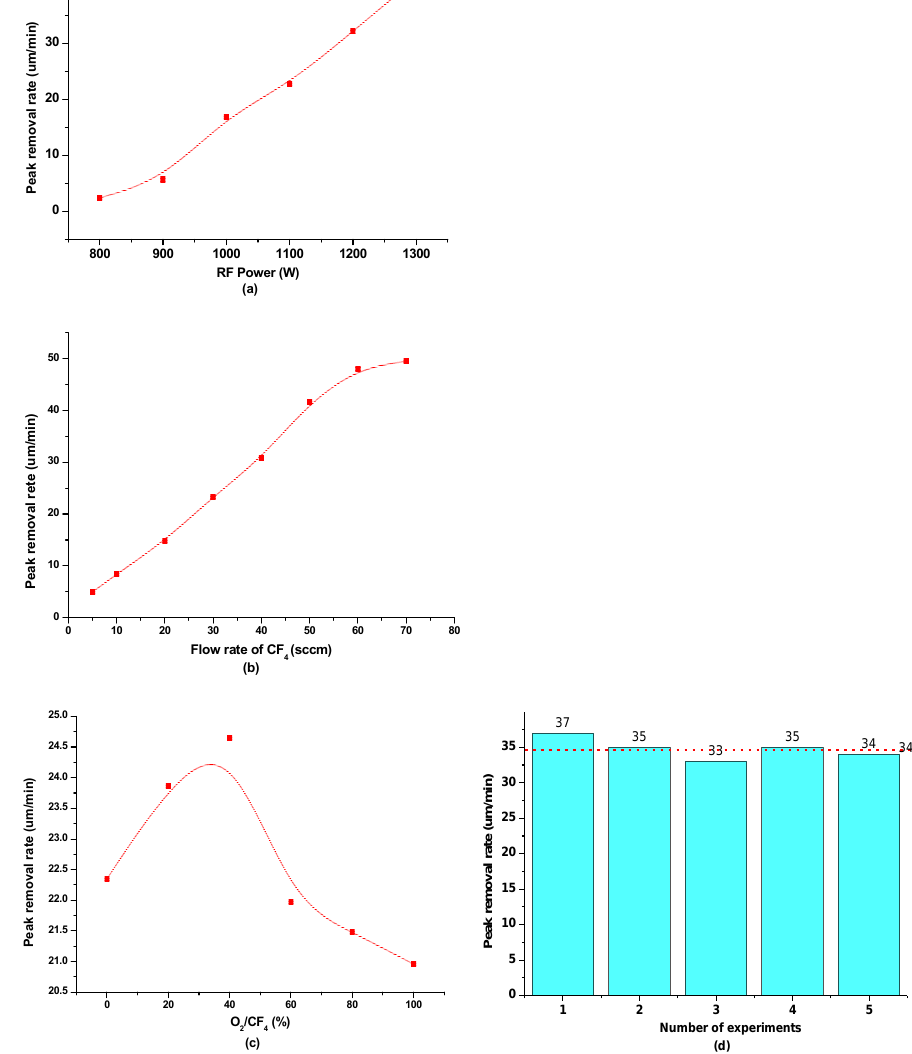
Figure 3. Influence on peak removal rates of plasma parameters. ( a ) RF power. ( b ) Flow rate of CF 4 . ( c ) O 2 /CF 4 ratio. ( d ) Repeatability of the removal function.